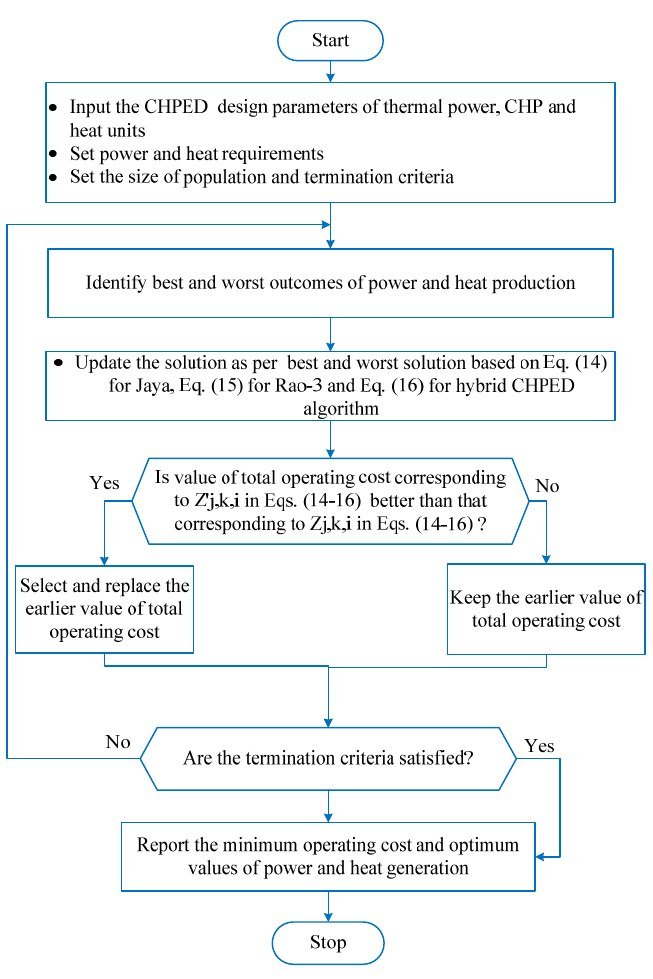
Figure 2. Flow chart of the proposed CHPED algorithm.